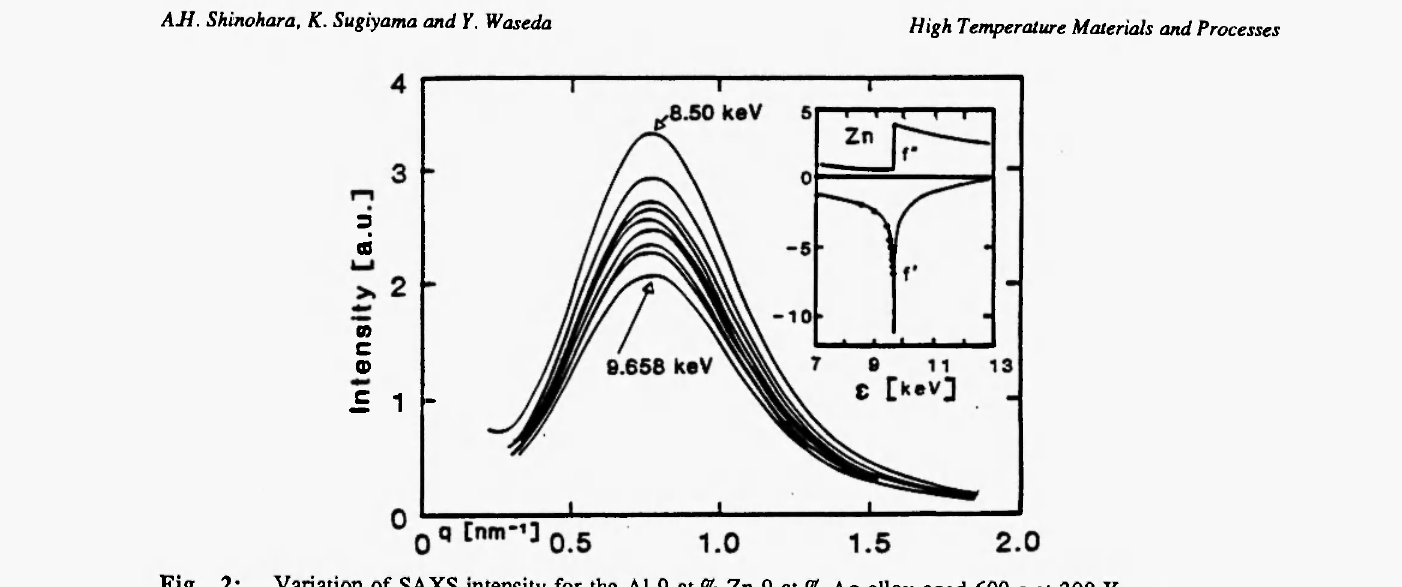
Fig. 2: Variation of SAXS intensity for the Al-9 at.% Zn-9 at.% Ag alloy aged 600 s at 398 Κ upper to lower curves have been recorded at X-ray energies of 8.50, 9.00, 9.40, 9.56, 9.625, 9.64, 9.651 and 9.658 keV /2/. Since all enegies are located below absorption edge, the theoretical values are given in the insert figure /24/.